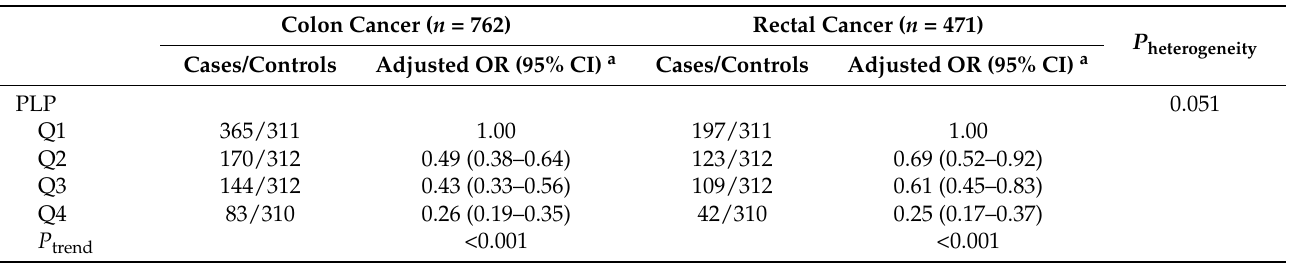
Table 5. Odds ratios and 95% confidence intervals of colorectal cancer according to quartiles of serum PLP, PL plus PLP, and PAr values by cancer